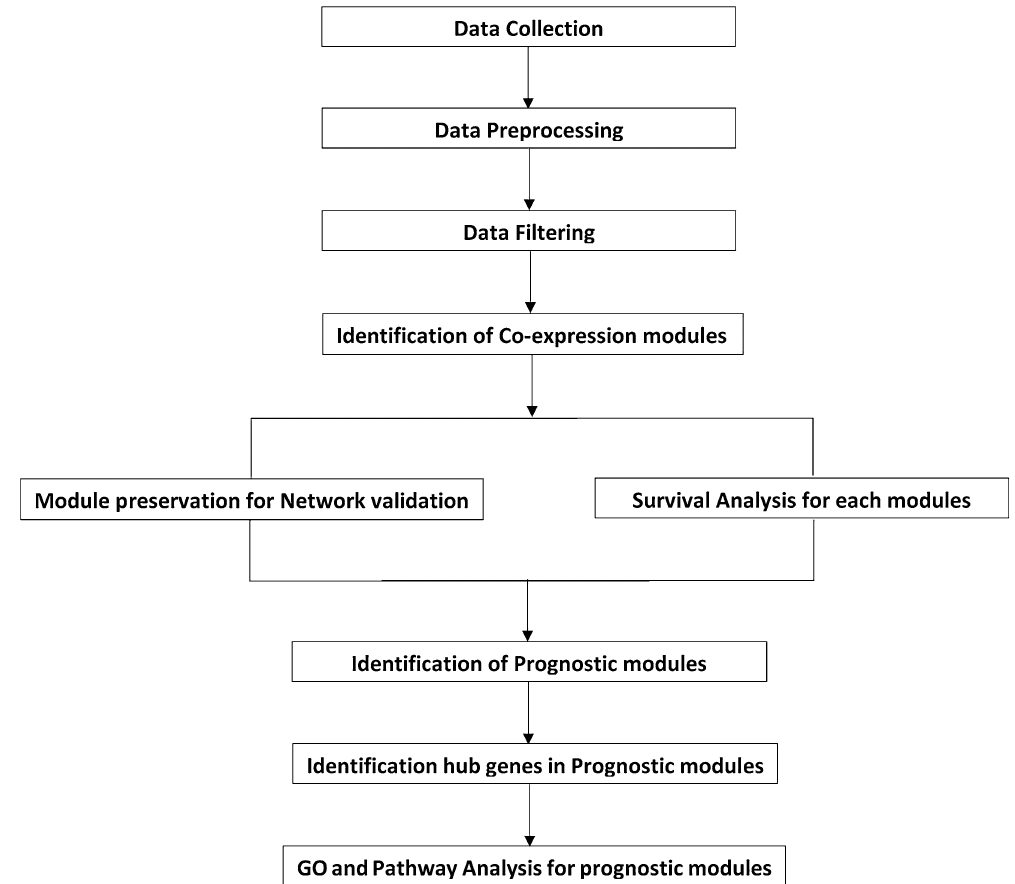
Figure 5. Flow chart of sequential steps for data preprocessing and analysis. Data Prep-aration includes data collection, preprocessing, and filtering. Three data sets were downloaded; the first one was TCGA